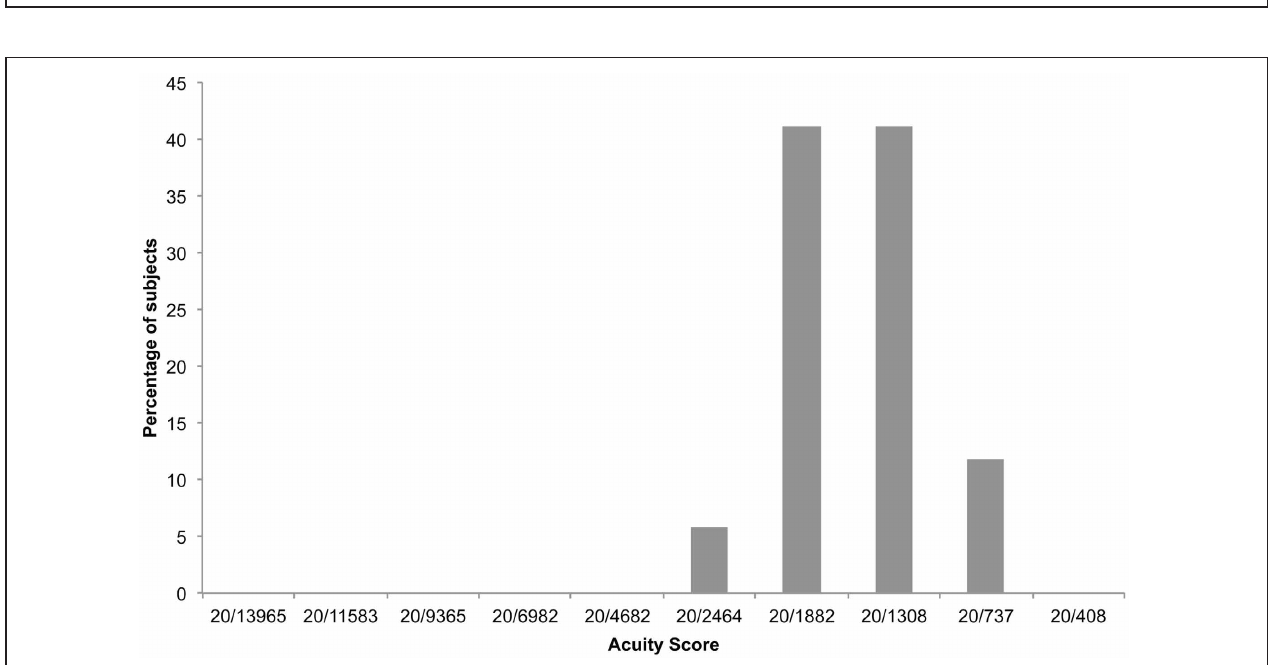
FIGURE 5 | Percentage of participants who achieved each vOICe acuity score (8/12 correct responses) in experiment 2.